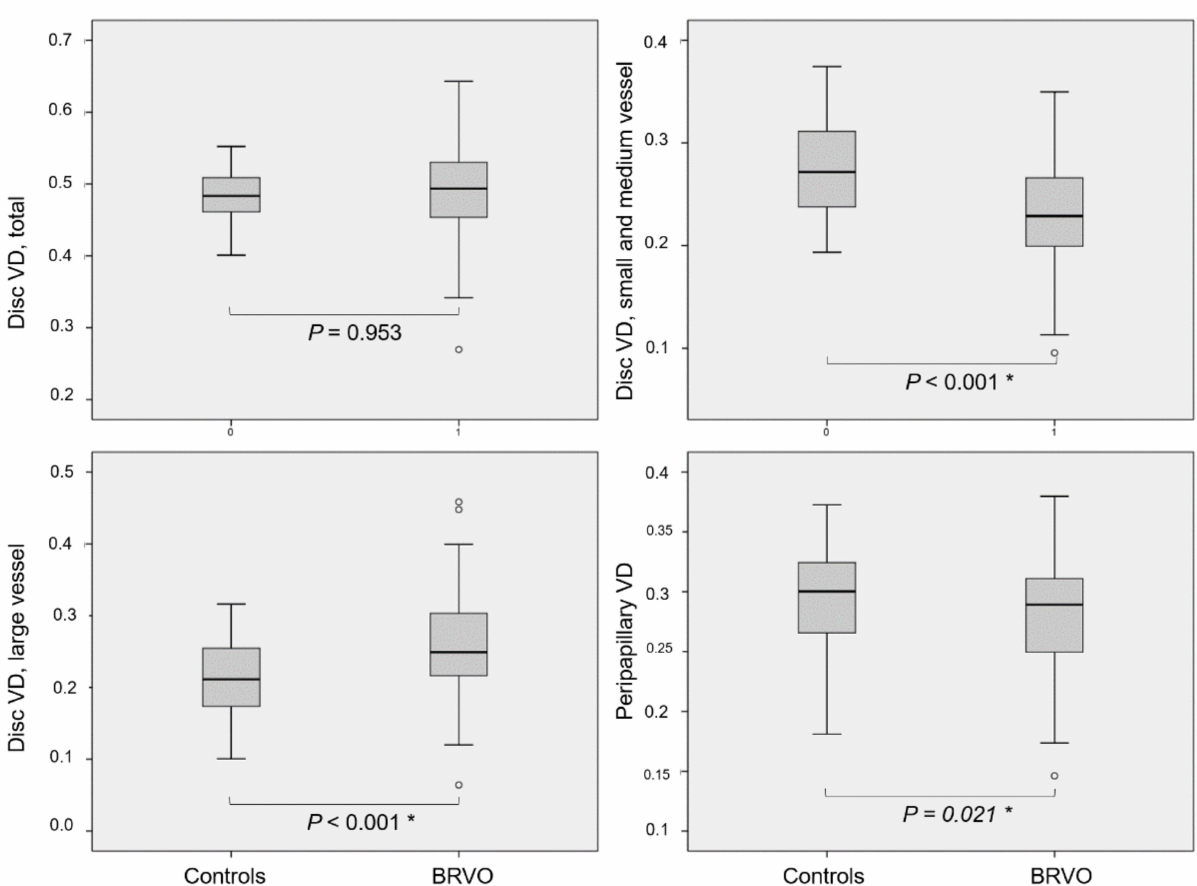
Figure 2. VDs of the disc and peripapillary areas of patients with NTG, according to BRVO status. Small and medium and large vessel VDs in the disc area differed significantly between patients with NTG, according to BRVO status (both P < 0.001). Peripapillary VD was lower in BRVO group than in control group ( P = 0.021).* Statistically significant P -value with Mann–Whitney U